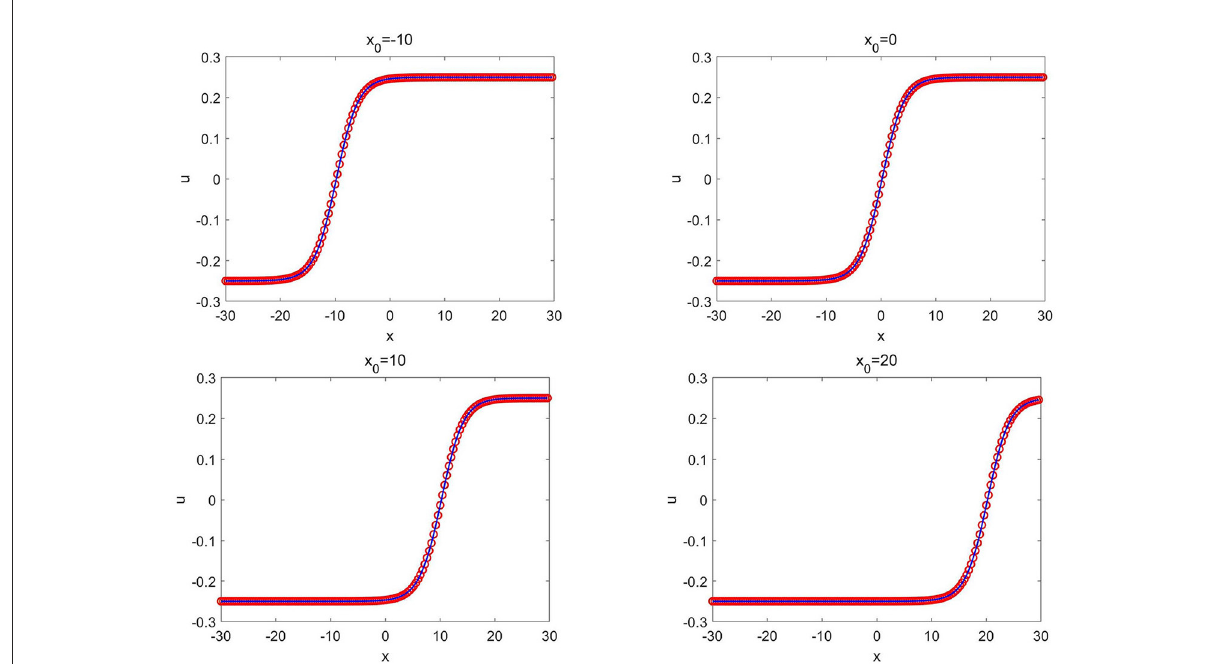
FIGURE10 Ito’s fifth order mKdV equation of Example 3.7: the CANN solution (red circles) and the exact solution (solid blue lines) at T x 0 where κ 0.25 is fixed. =